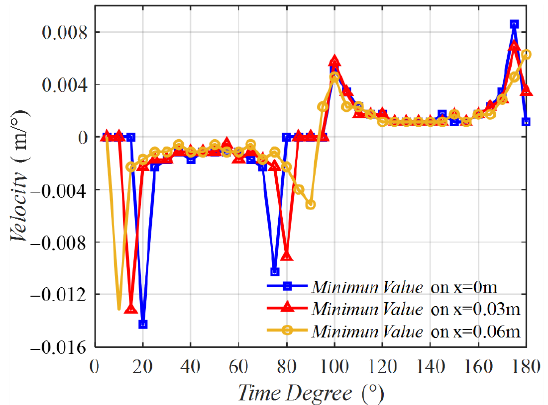
Figure 6. Velocity on three middle lines varying with time degrees.